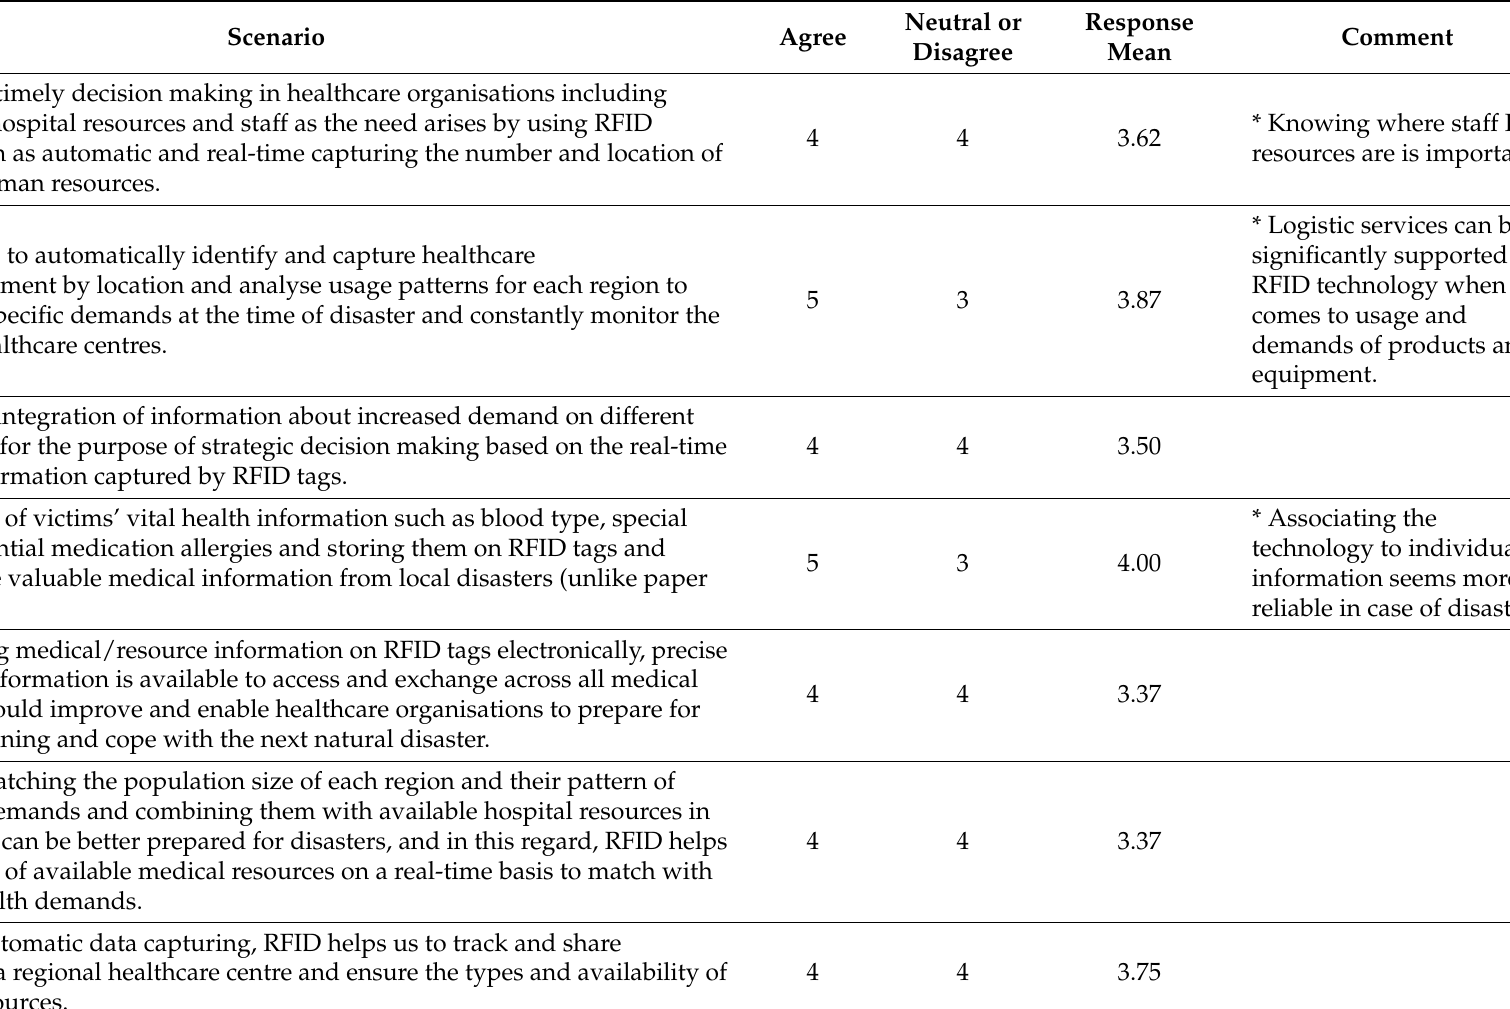
Table 3. Round 1 of RFID scenario applications in DMC and experts’